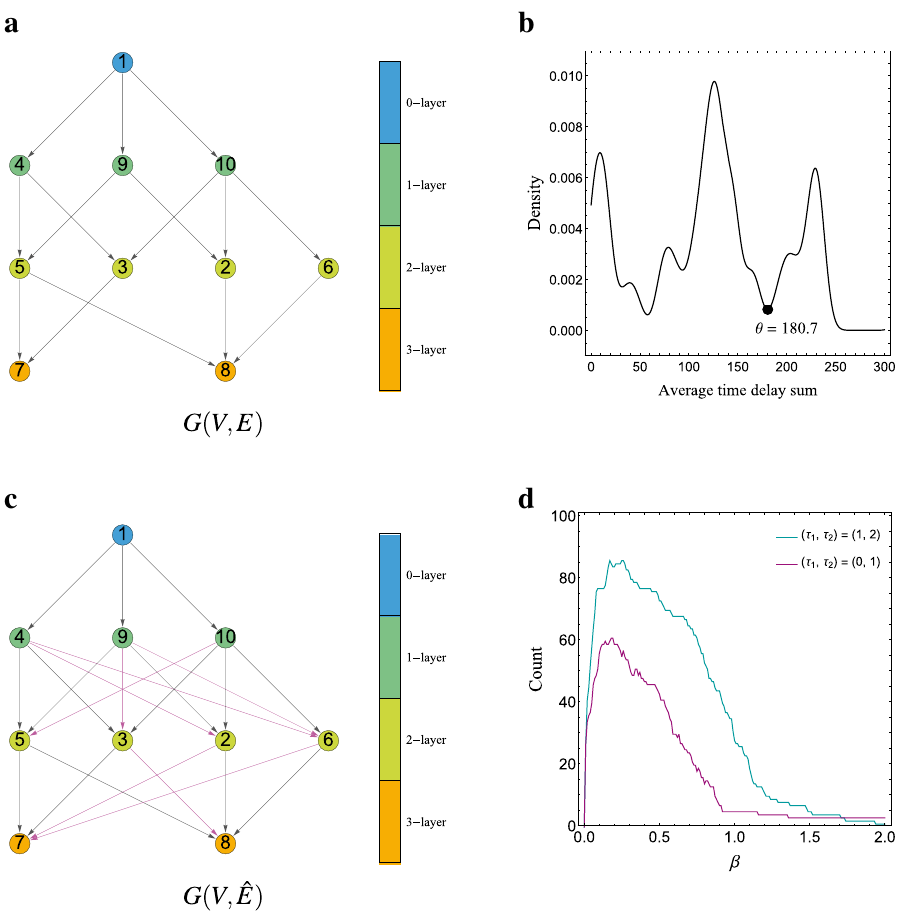
Figure 2. ( a ) Ground truth graph G ( V , E ) in the experiment of real-valued state propagation using synthetic datasets. ( b ) The probability density of average time delay sum estimated by kernel density estimation for one of the synthetic datasets. The black circle ( θ = 180.7 ) indicates a threshold value adopted by our method. ( c ) The estimated graph G ( V , ˆ E ) from one of the datasets by the proposed method. In G ( V , ˆ E ) , black and magenta arrows are edges in E and ˆ E \ E , respectively. Each vertex’s color indicates its belonging layer. ( d ) The number of datasets in which parameter β of the bandwidth achieves the minimum